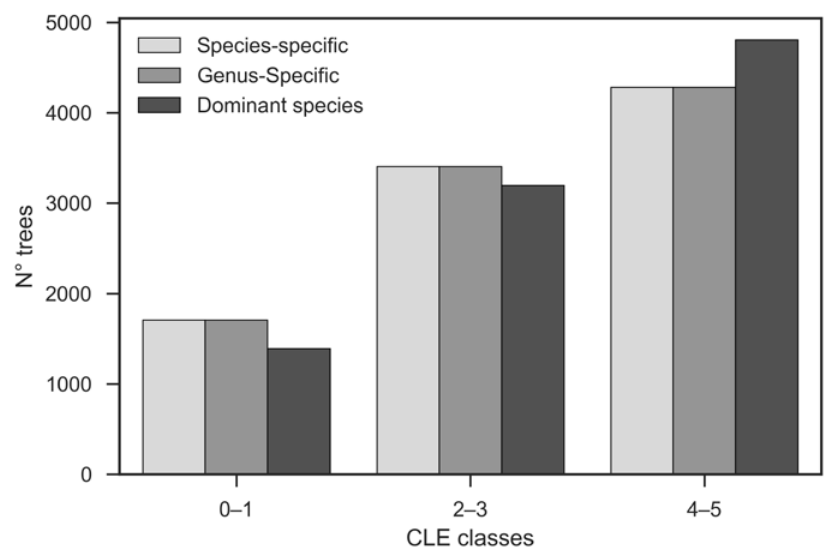
Figure 6. Comparison of crown light exposure (CLE) classes between the “species-specific”, “genus-specific”, and “dominant species” simulations. Class 4–5 (open-grown trees) is dominant in all simulations, particularly in the “dominant-species” simulation (99.4% of Acer platanoides ).